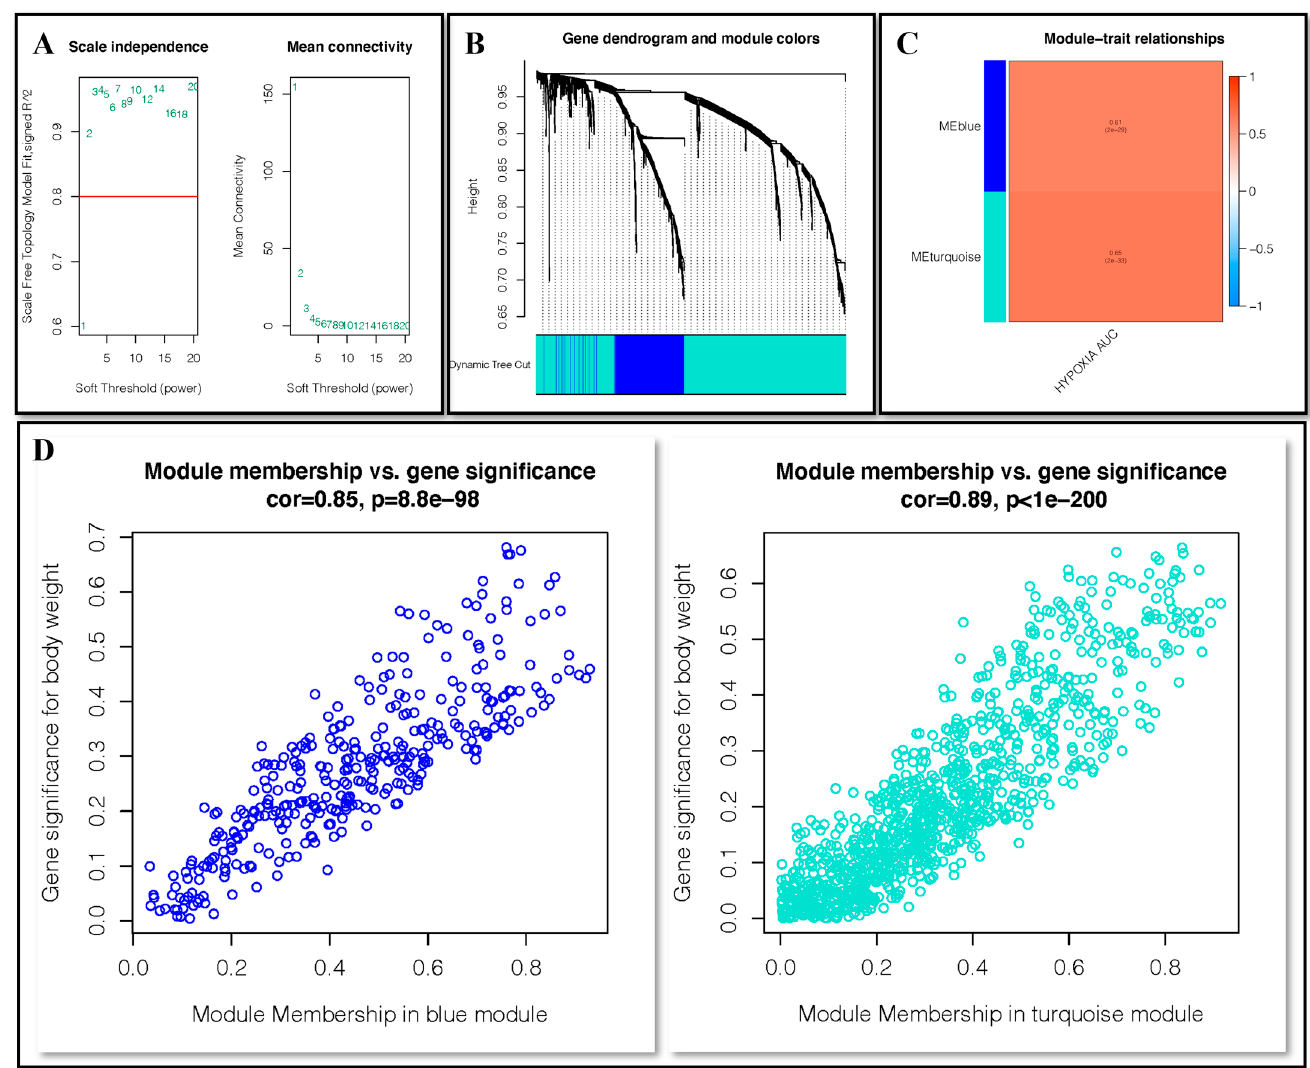
Figure 3. WGCNA analysis. ( A ) Setting the soft threshold. ( B , C ) Genes were clustered into two modules, blue and turquoise. ( D ) Correlation between module membership and gene significance in blue and turquoise modules.